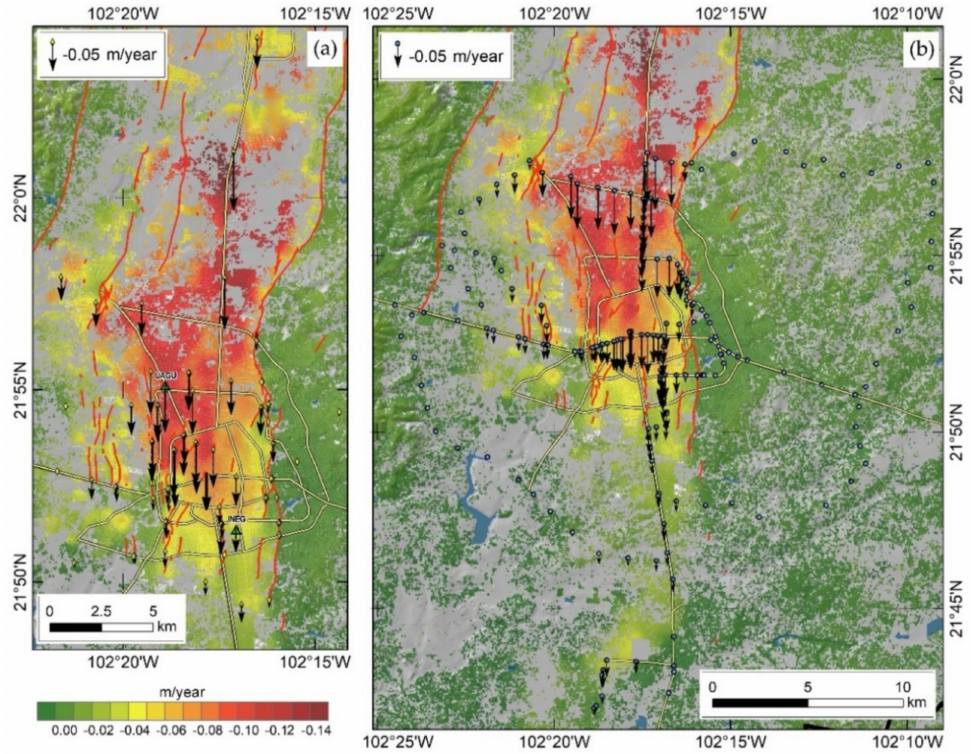
Figure 7. Height velocities ( V U ) from geodetic data: ( a ) at the GNSS benchmarks and permanent stations and ( b ) at the leveling benchmarks; both plotted over PSI-derived vertical